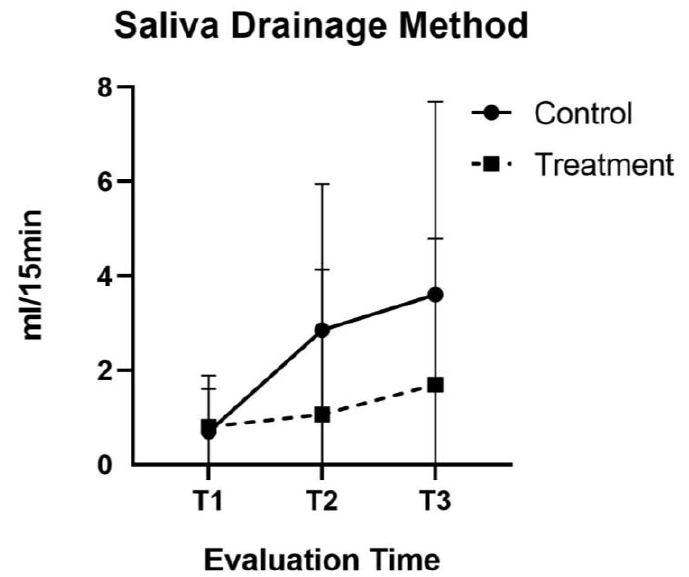
Table 1. Efficacy of photobiomodulation (PBM) applied over 6 consecutive weeks. with one session per week. (Treatment group and control group).